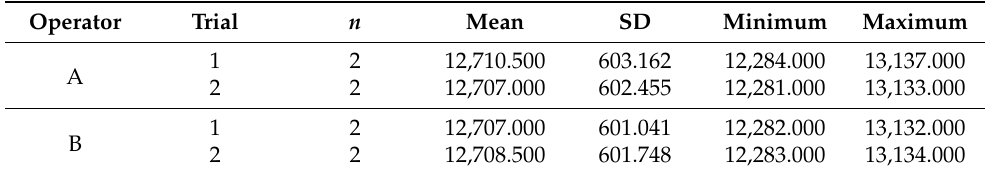
Table 2. Descriptive statistics for the two measurements performed by the two operators for the Gage R&R statistical